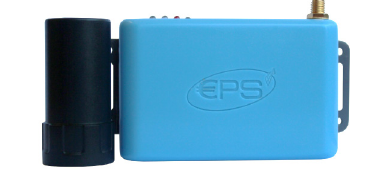
Figure 2. EPSKit-7 with antenna type Helix